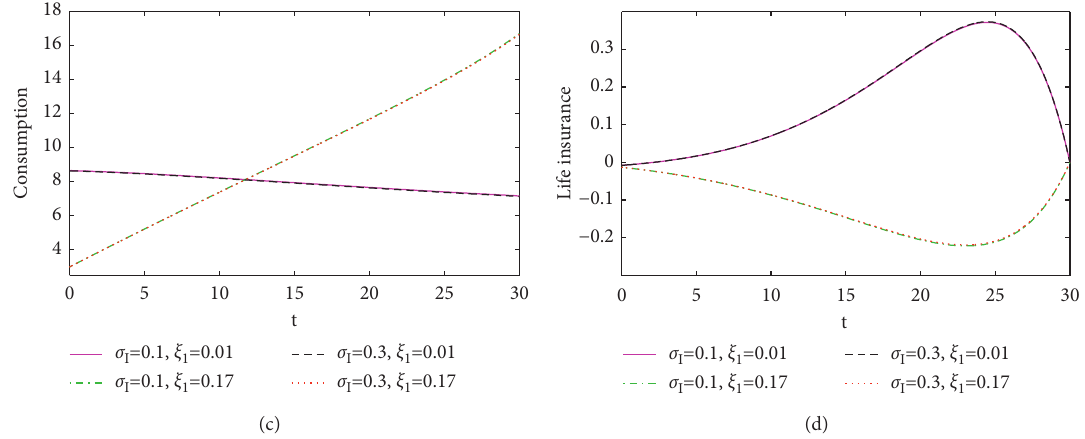
Figure 2: The effects of the inflation rate volatility and consumption habit on the optimal strategies.